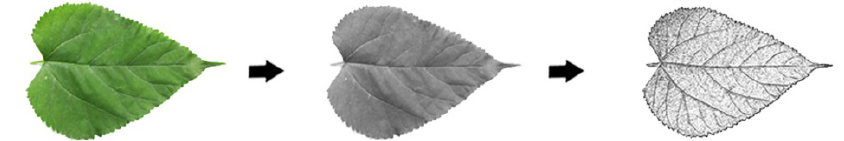
Fig. 3. Illustrated image with the adaptive local threshold to mean (10), C ¼ 0 : 2 .